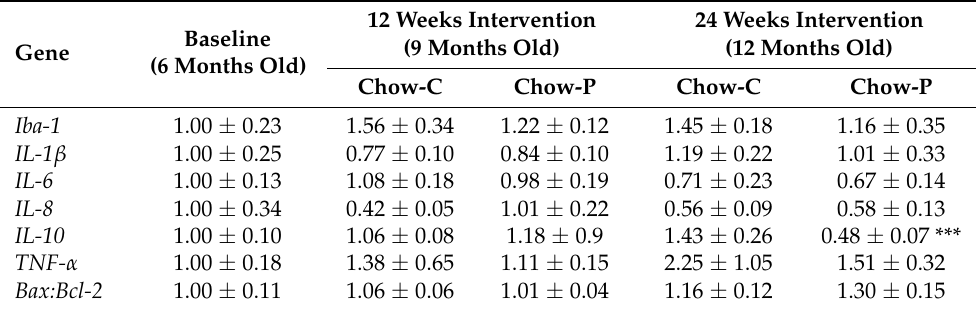
Table 1. Fold change in mRNA expression in the hippocampus of 3xTg-AD mice (Study A). Shown are changes from baseline in mRNA expression in the hippocampus of 3xTg-AD mice receiving chow alone (Chow-C) or chow plus Lab4P (Chow-P) for 24 weeks (Study A). mRNA expression is presented as a mean fold change ± standard error of the mean (SEM) of five mice compared to baseline that has been arbitrarily set as 1. Values of p were determined using one-way ANOVA with Tukey’s post hoc analysis where *** indicated p < 0.001 versus the control. Abbreviations: Iba-1 , ionized calcium-binding adaptor protein-1; IL , interleukin; TNF- α , tumour necrosis factor- α ; Bcl-2 , B-cell lymphoma 2 gene; Bax , Bcl-2 -associated X apoptosis regulator. 12 Weeks Intervention 24 Weeks Intervention Baseline (9 Months Old) (12 Months Old) Gene (6 Months Old) Chow-C Chow-P Chow-C